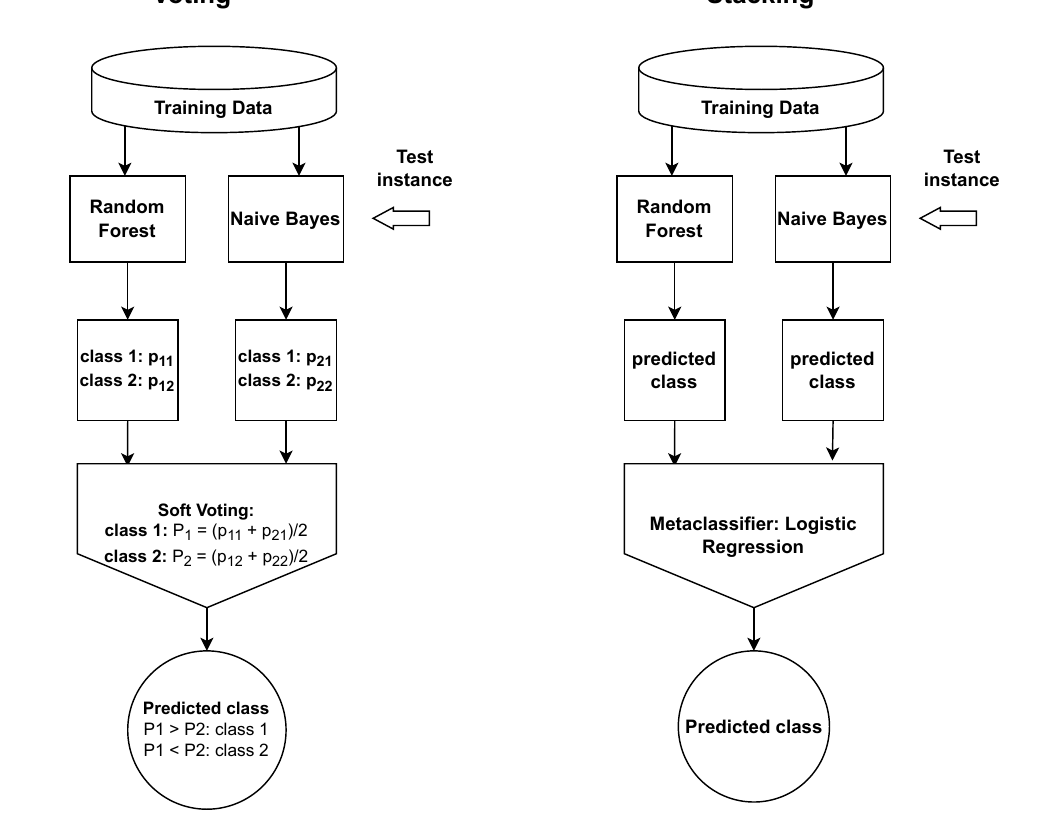
Figure 1. An overview of the Voting and Stacking ensemble